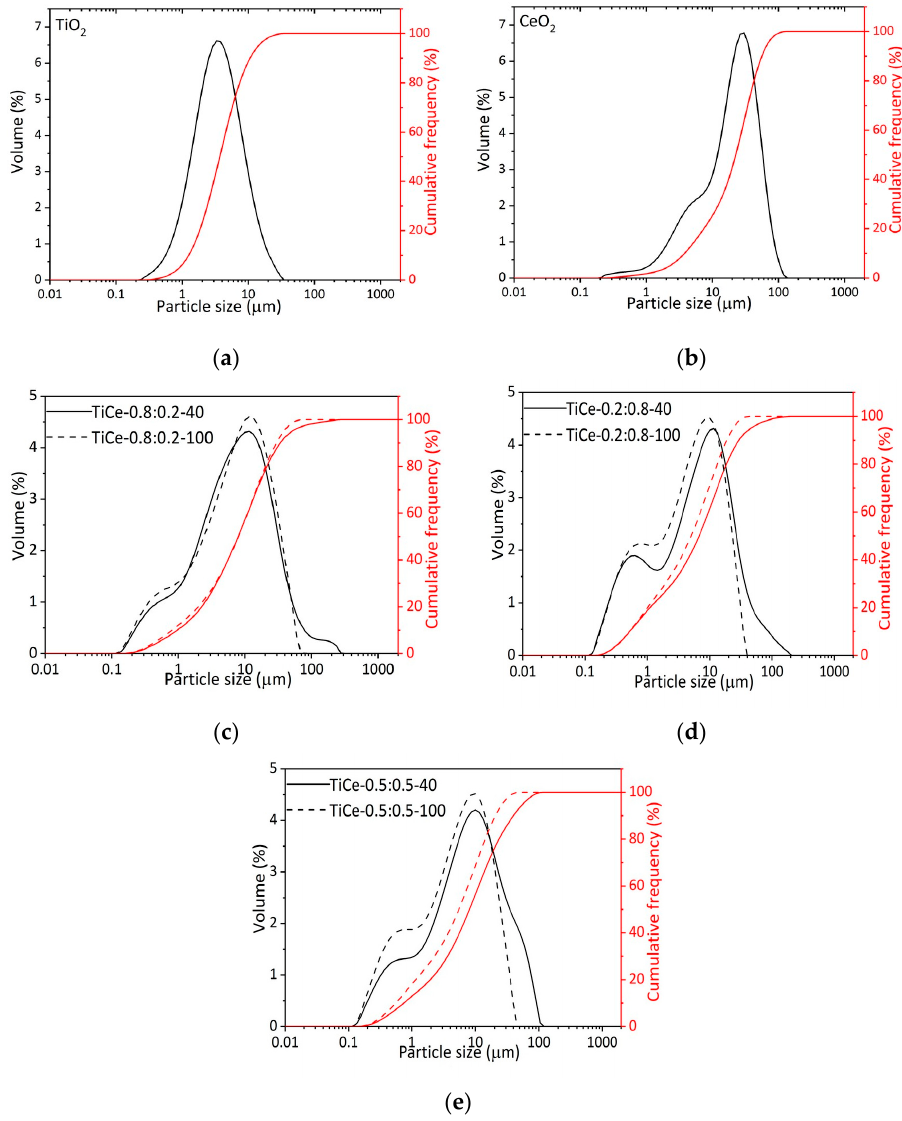
Figure 2. Volume-based particle size distribution and cumulative frequency of: ( a ) TiO 2 ; ( b ) CeO 2 ; ( c – e ) mixed oxide